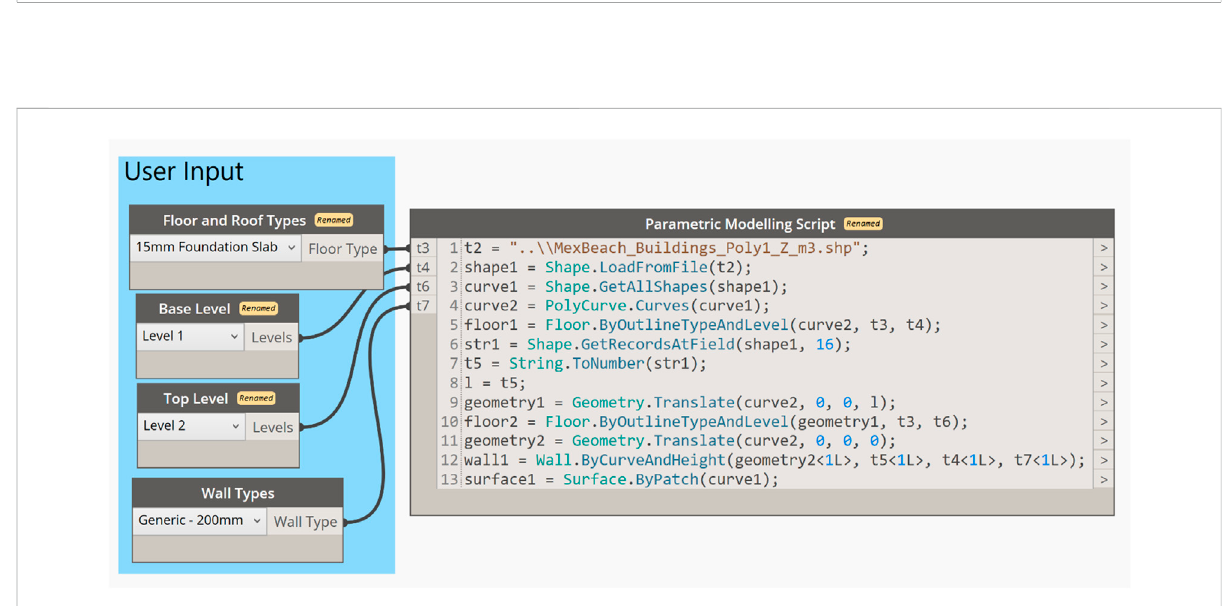
FIGURE 3 The parametric BIM modeling Python algorithm to convert the 2D building footprint to a 3D solid building.